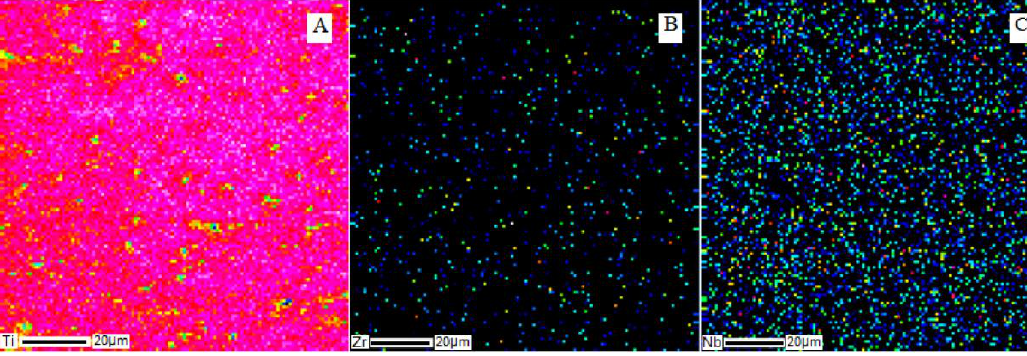
Figure 4. Elemental distribution of metals in the structure of the Ti–28Nb–5Zr alloy after annealing at 900 °C for 12 h: ( A ) titanium; ( B ) zirconium; ( C ) niobium.